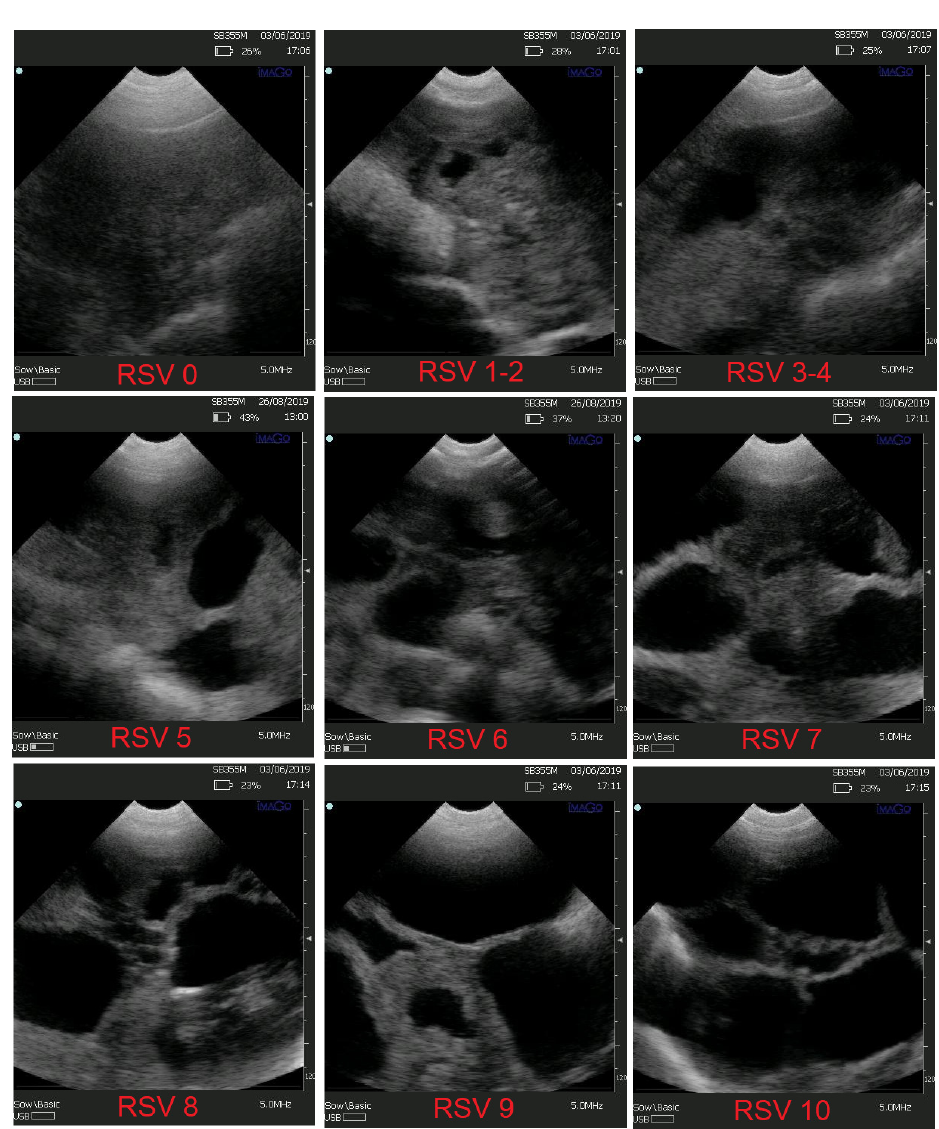
Figure A1. The 10-point rating scale for the pregnancy diagnosis estimation. RSV = 0: complete absence of pregnancy indications, RSV = 1–2: low suspicion for pregnancy-typical image within 20 days post-insemination, RSV = 3–4: reasonable suspicion for pregnancy-typical image within 20–24 days post-insemination, RSV = 5: guaranteed pregnancy with possible small litter size, RSV = 6: guaranteed pregnancy of medium litter size, RSV = 7: guaranteed pregnancy with possible larger litter size, RSV = 8: guaranteed pregnancy of satisfactory litter size, RSV = 9: guaranteed pregnancy of possibly great litter size—typical image at least 25 days post-insemination, RSV = 10: great litter size. Adopted from: 17. Kousenidis, K.V.; Kostoulas, P.; Karageorgiou, E.; Lymberopoulos, A. 2021. Prediction of the Expected Litter Size from the Real-Time Ultrasound Imaging of Pregnant Sows, with Machine Learning. In Proceedings of First ESDAR-ECAR Virtual Conference, 11–16 October